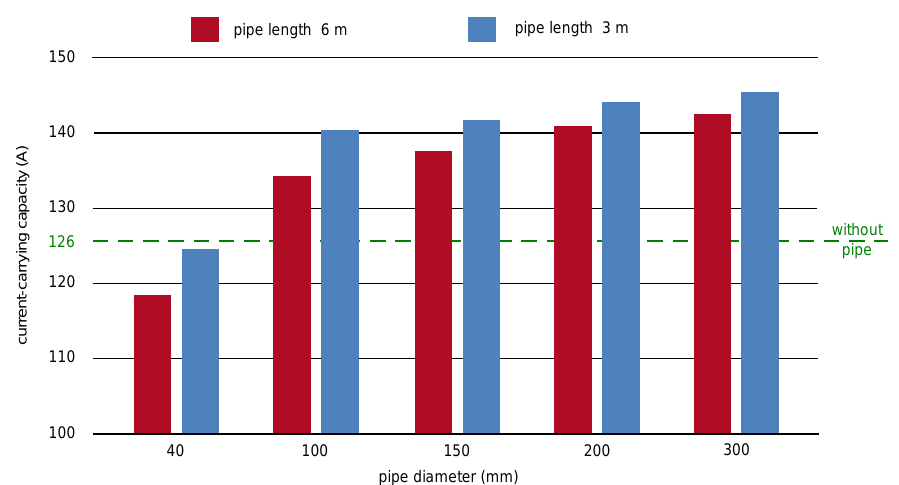
Figure 15. The current-carrying capacity of the power cable depending on the diameter and length of the casing pipe.